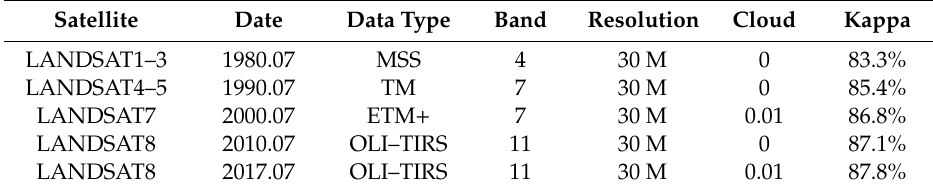
Table 1. Remote sensing information at di ff erent times.